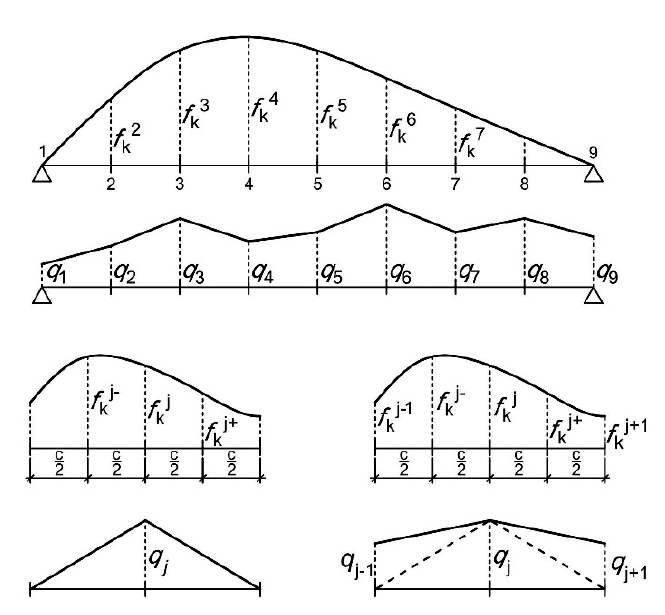
Figure 11. Function of the influence and load in modelling scheme